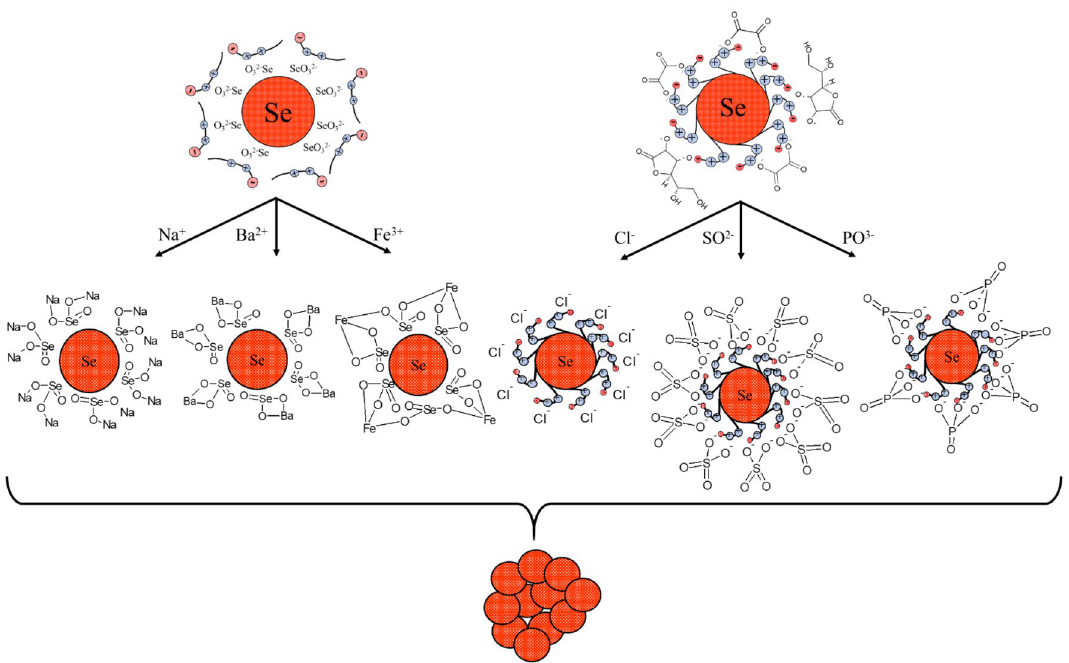
Figure 14. Schematic illustration of coagulation of positive and negative Se NPs sols with different